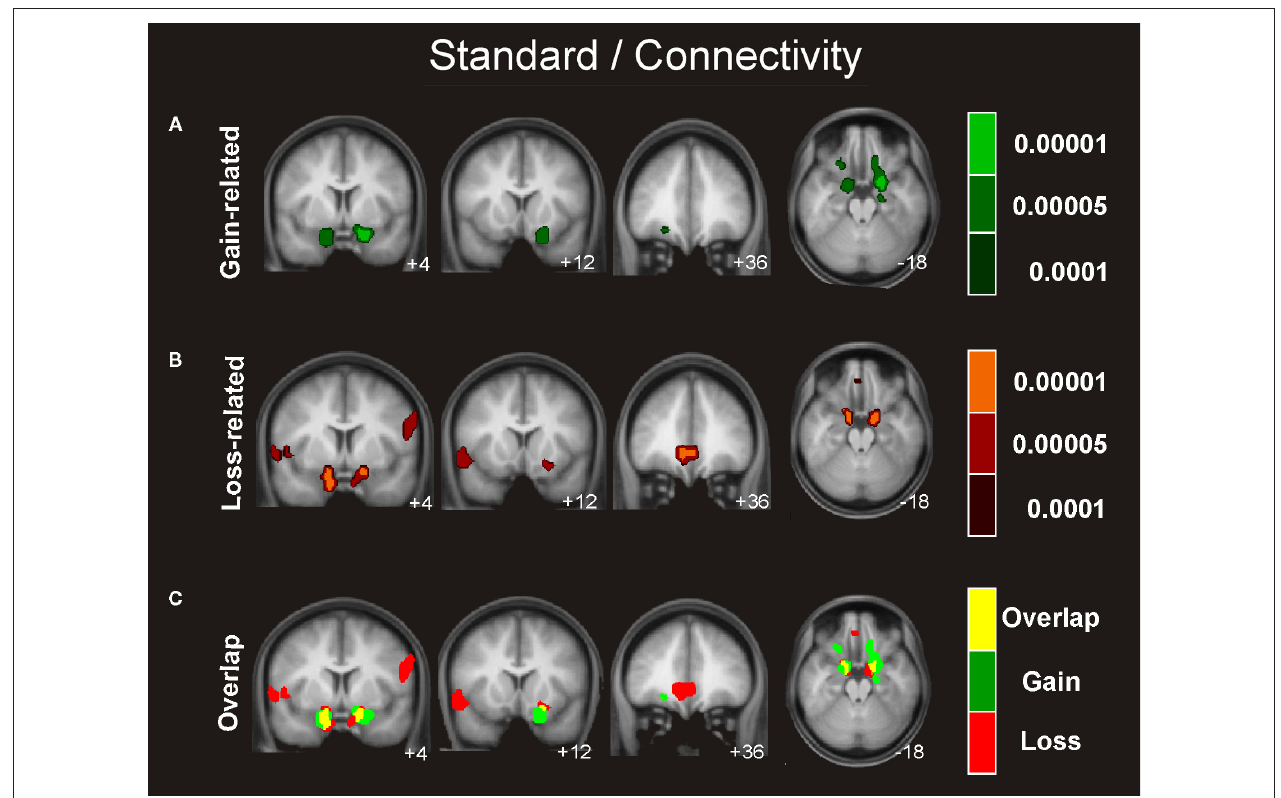
reward (A) , and punishment (B) condition using different statistical thresholds ( P < 0.0001; P < 0.0005; P < 0.001). Gains and losses connectivity patterns are simultaneously depicted in (C) : gain (green, P < 0.001), loss (red, P < 0.001), and conjunction gain (cid:2) loss (yellow, P < 0.001 and P <